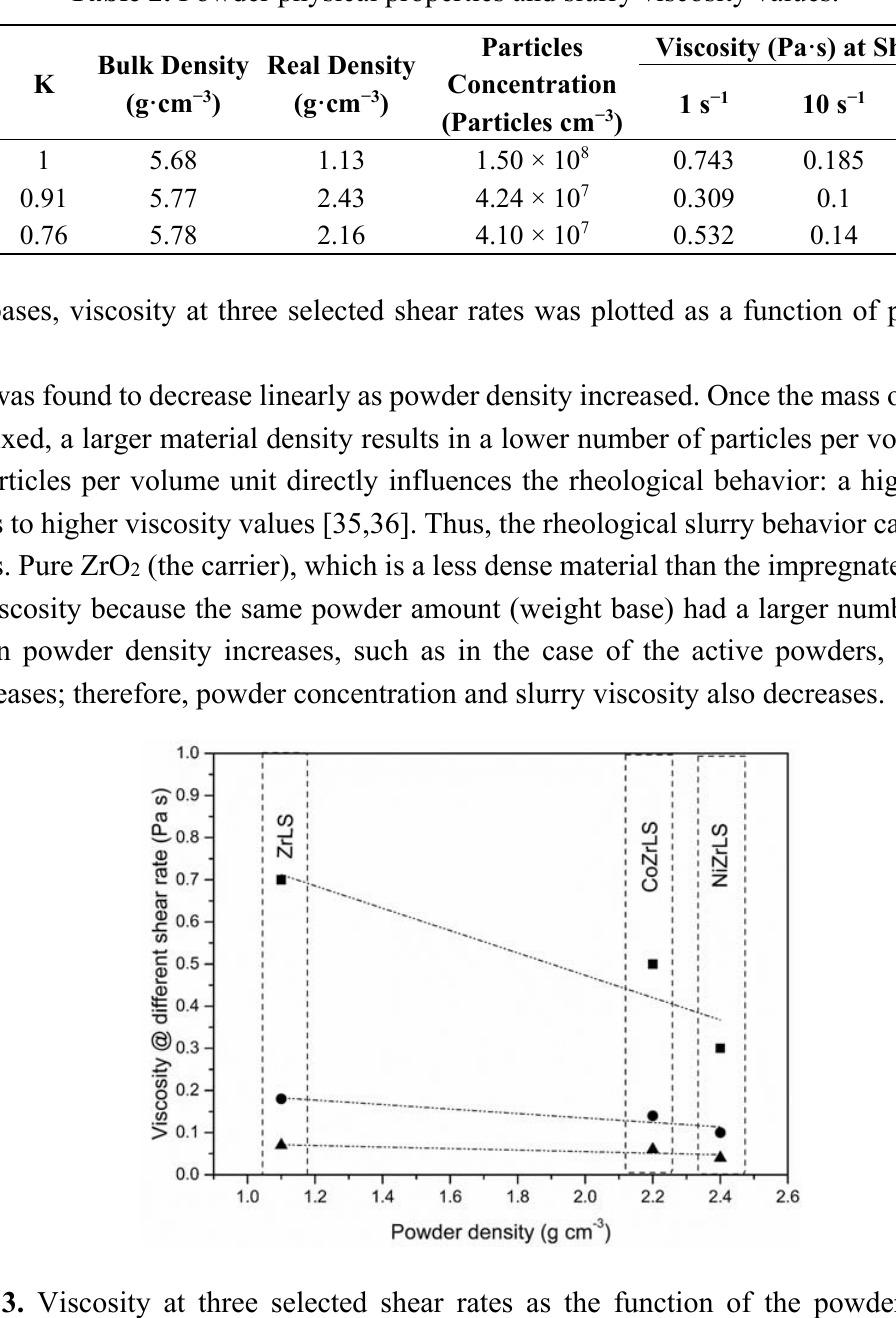
Table 2. Powder physical properties and slurry viscosity values.